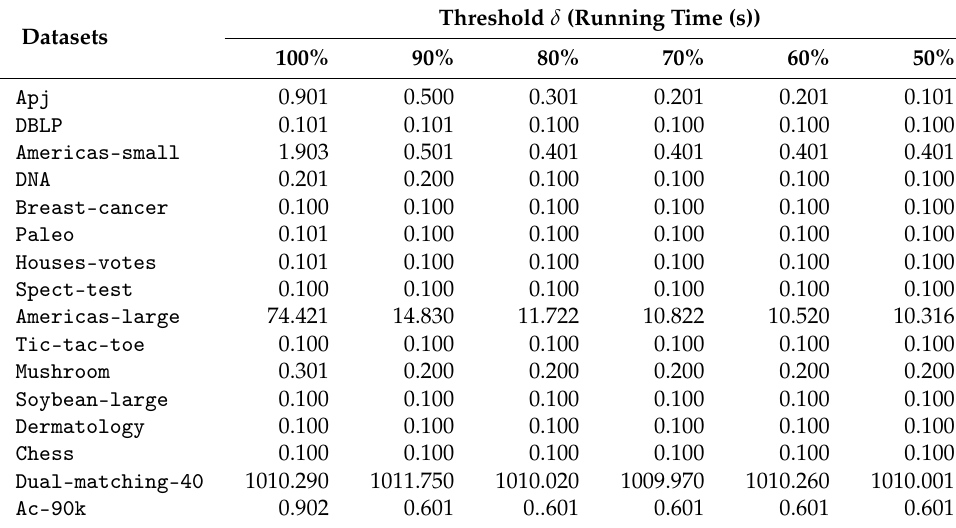
Table 15. The running time of the C ONCISE algorithm with different